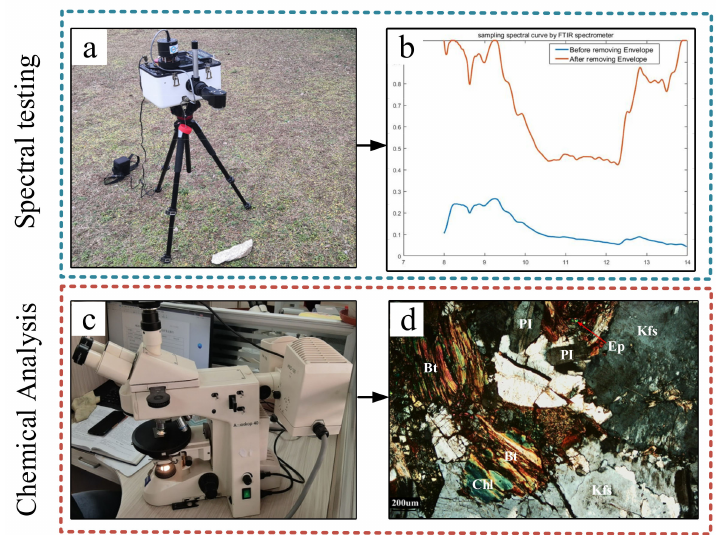
Figure 9. Experimental sample and analysis operation. ( a ) 102F Fourier Transform Infrared spectrom- eter for spectral testing, ( b ) the spectral data (8–14 µ m) measured by the spectrometer and the curve after removing the envelope, ( c ) Axioskop40 microscope, ( d ) the identification result indicates the mineral component of plagioclase (PI), K-feldspar (Kfs), biotite (Bt), chlorite (Chl), and epidote